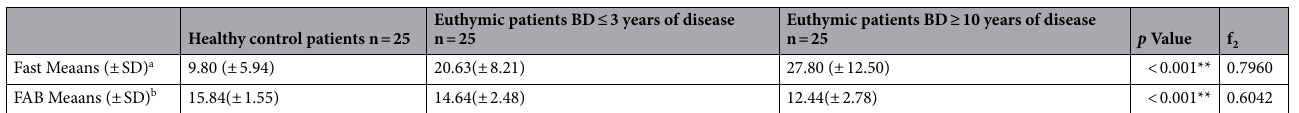
Table 4. Mean total of FAST and FAB scores in healthy controls and euthymic patients with ≤ 3 and ≥ 10 years of the disease. Means ± standard deviation (SD). FAB = Frontal Assessment Battery FAST = Functioning Assessment Short Test. The normality of each variable was analyzed using the Kolmogorov–Smirnov normality test. a To compare nonparametric variables between the three independent samples, the Kruskal–Wallis test was used. Dunn’s post hoc test was performed for pairwise comparisons if the main effects were significant. b To compare parametric variables between the three independent groups, two-way analysis of variance (ANOVA) followed by Tukey’s test was used. Statistical significance was set at ** p < 0.001 for all tests. f 2 = the overall Cohen’s effect size. Image origin: Cyrino et al., (2021). Assessment of different domain impairments in Cognitive Functions and Functionalities found in Euthymic Patients with Bipolar Disorder I / II—during the early and late phases of the disease, using the FAB and FAST tests. International Journal of Advanced Engineering Research and Science (IJAERS). 8, 401–433.